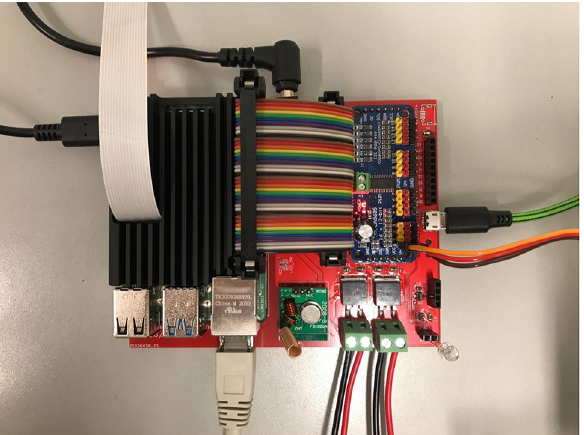
Figure 3. The hardware for controlling the experiments. The red printed circuit board (PCB) is the one designed by the authors, connecting the single-board computer (SBC) with everything else. The blue PCB is a servo controller, which drives the servo motor to turn on the aerosol generator. The green PCB is a 433 MHz transmitter, which can switch power outlets on or off, which are connected to the air purifier, for